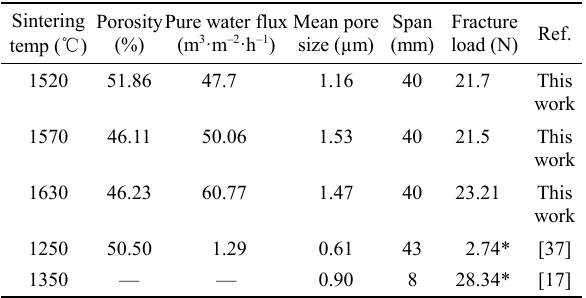
Table 2 Performances of mullite hollow fiber membranes